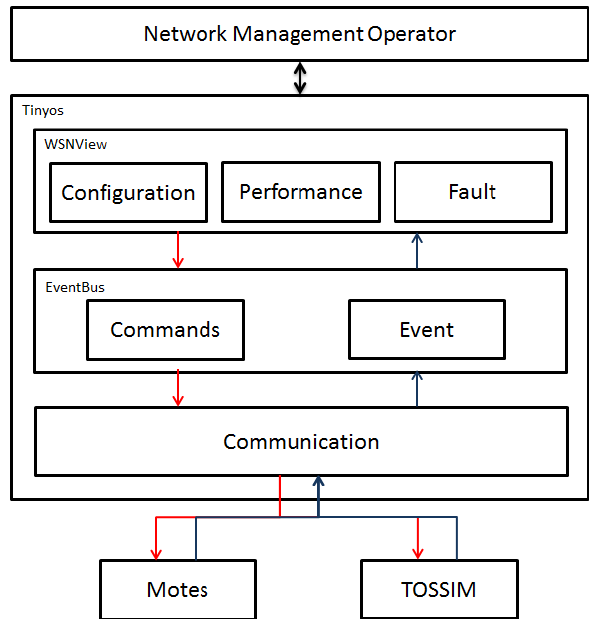
Figure 3. WSNManagement System